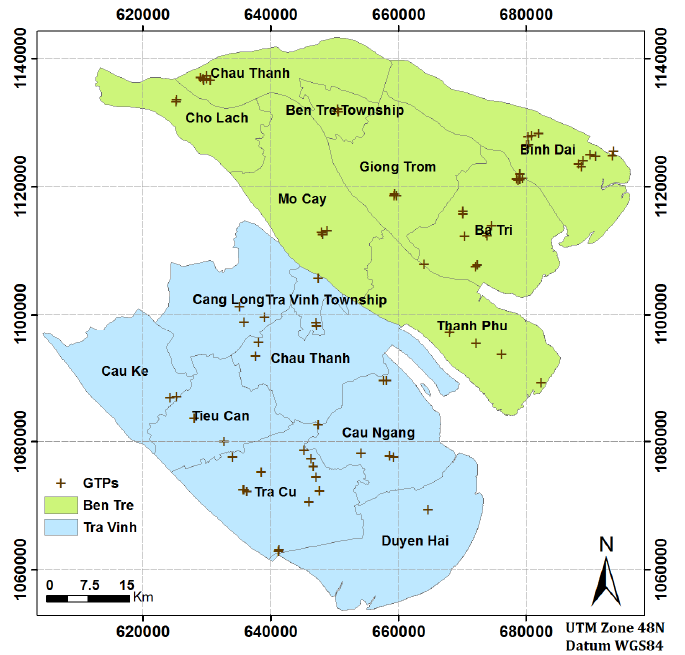
Figure 1. A district map of the study area with the ground truth point (GTP)